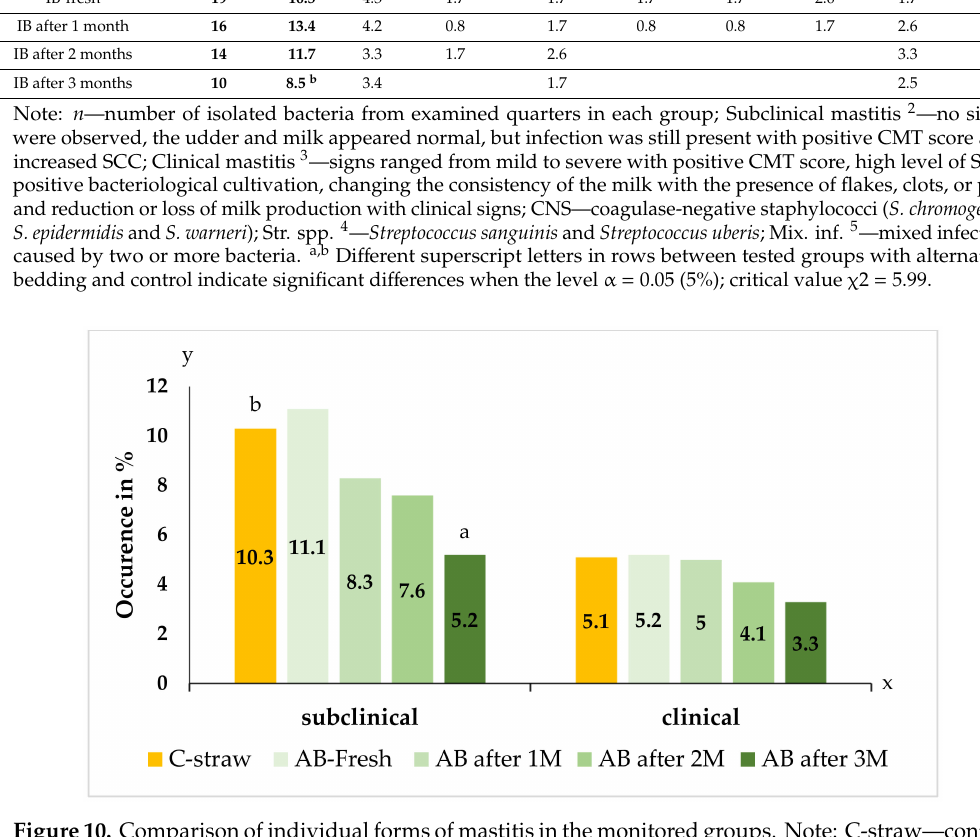
Figure 10. Comparison of individual forms of mastitis in the monitored groups. Note: C-straw—control group of cows housed in cubicles that were not emptied of straw bedding, but the cubicles were re-bedded once a day with fresh straw; AB-Fresh—cubicles bedded with one-day-old (fresh) alternative bedding; AB after 1M—one month after use of alternative bedding; AB after 2M—two months after use of alternative bedding; AB after 3M—three months after use of alternative bedding; a,b values above the column with di ff erent superscript letters di ff er significantly when the level α = 0.05 (5%);